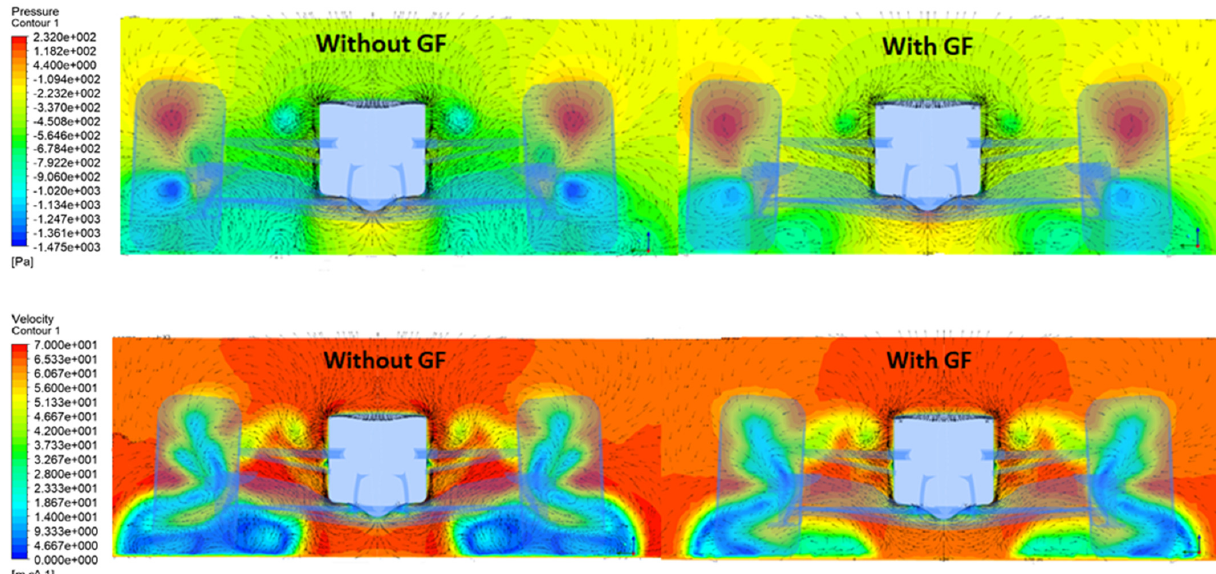
Figure 11. Comparison on the on the x 3 plane of distributions between the case with and without GF: ( above ) pressure contours with velocity vectors, ( below ) velocity contours, and vectors.